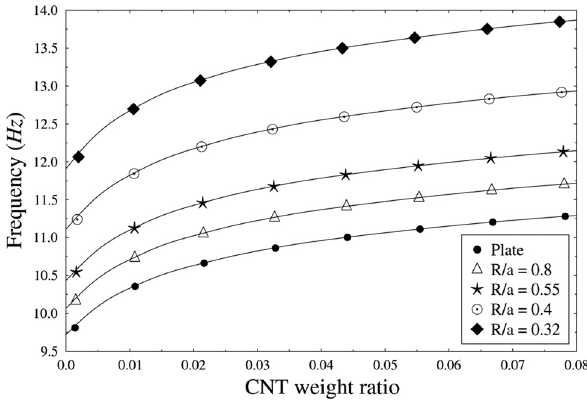
Figure 7: Induced natural frequencies of CNTFPC cylindrical panels for di ff erent SWCNT weight ratios and